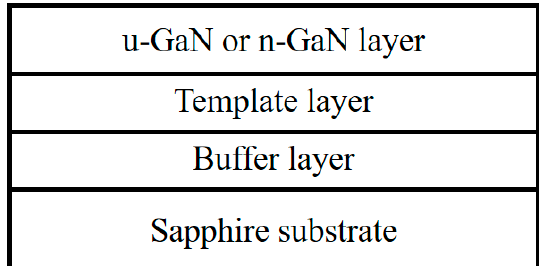
Figure 1. Schematic diagram of the epitaxial structure of GaN samples.